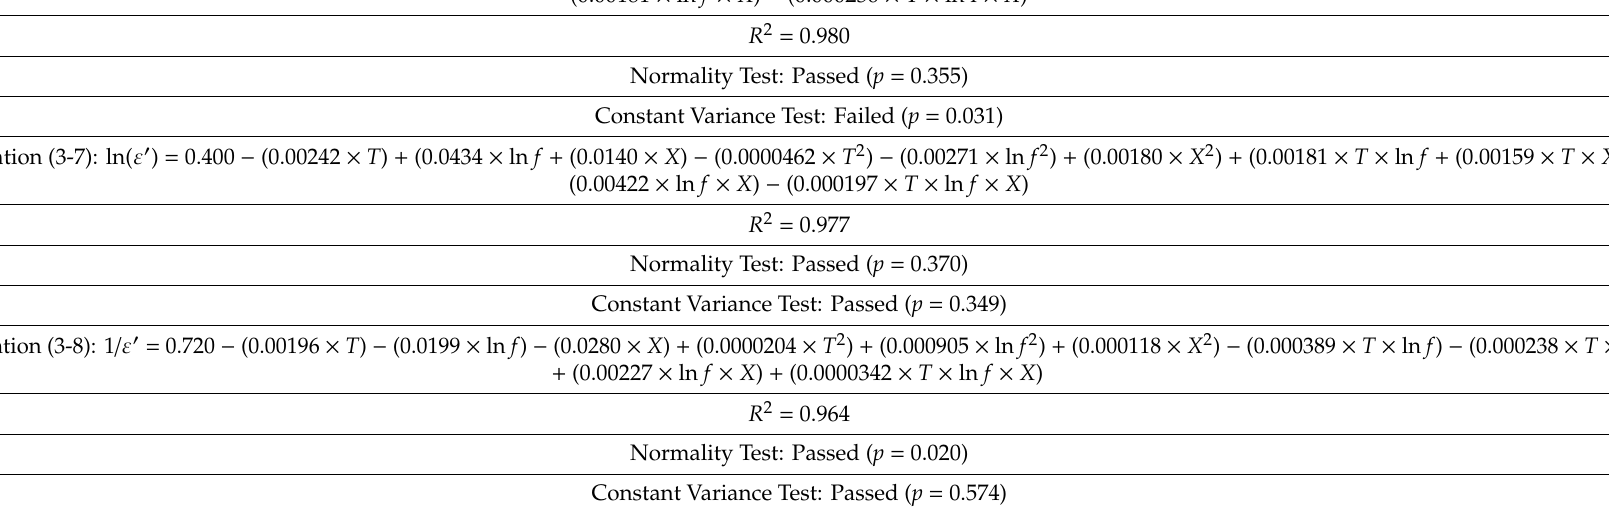
(cid:112) ( ε (cid:48) ) = 1.390 − (0.00697 × T ) + (0.0246 × ln f − (0.0291 × X ) − (0.0000335 × T 2 ) − (0.00231 × ln f 2 ) + (0.00280 × X 2 ) + (0.00203 × T × ln f + (0.00193 × T × X ) Equation (3-6):